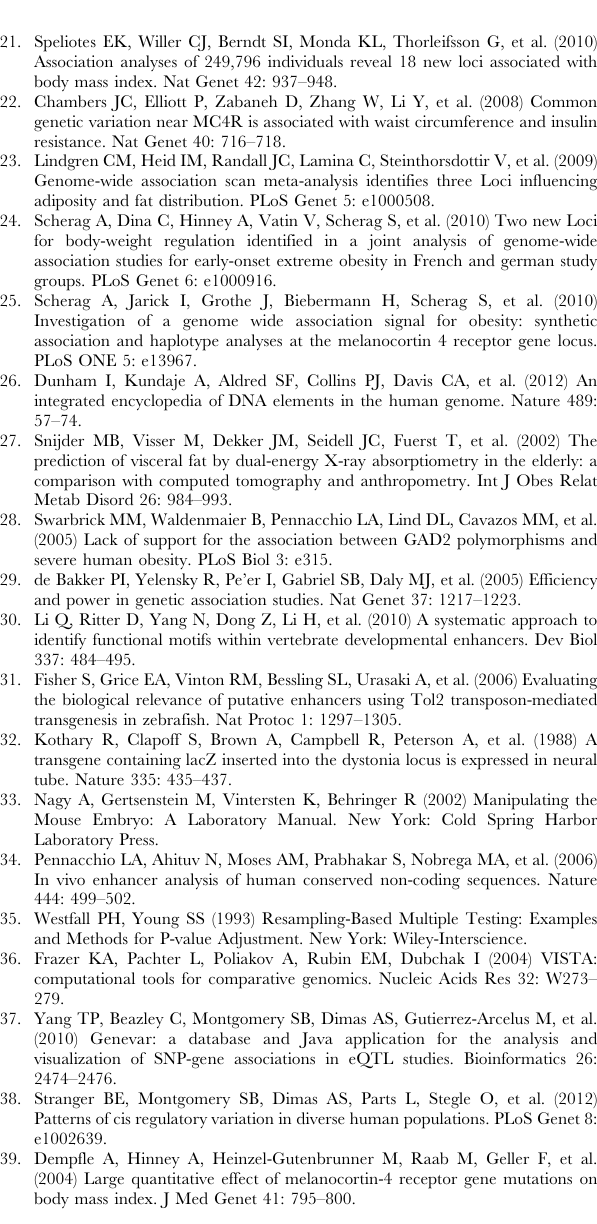
Table S2 SNP associations with adiposity-related traits in Health ABC black participants and stratified by sex. Table S3 Obesity association with rs11152221 using cases and controls from Health ABC white participants. Table S4 Characteristics of participants in case-control obesity study with cases from UCSF study. Table S5 Obesity association with rs11152221 using cases from UCSF study. Table S6 Characteristics of sequenced patients from UCSF study.